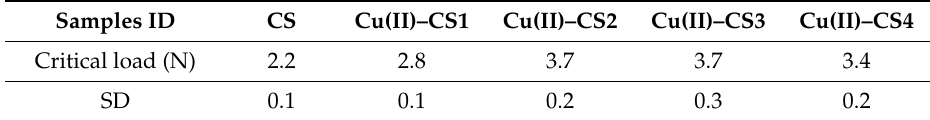
Table 3. Critical load values in scratch test with respect to standard deviations of CS and its complex